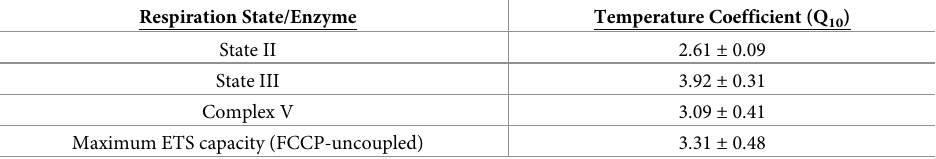
Table 1. Q 10 values for permeabilized brain respiration rates of mouse brain. Data were calculated from respiration rates of permeabilized brain tissue at both 28 and 37˚C (Fig 1). Data are mean ± SEM for n = 3–8